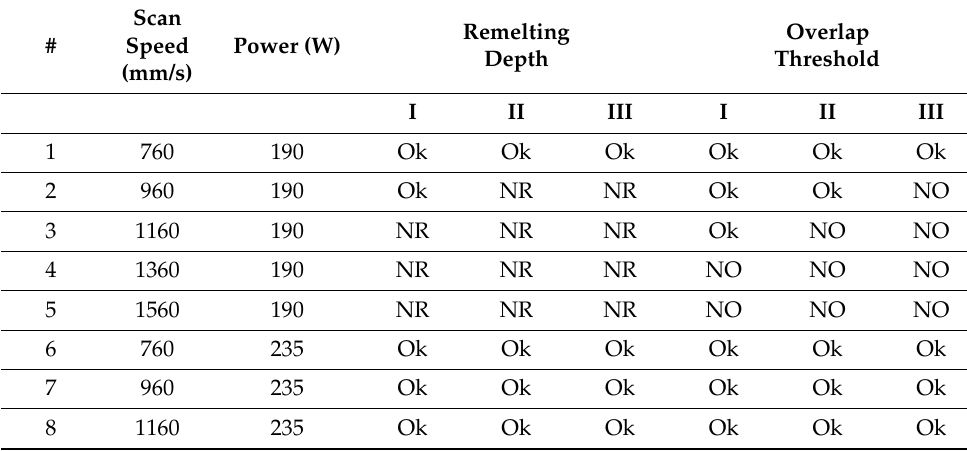
Table 9. Multi-tracks melt pool dimensions tracking table. The measure of each sample is referred to 0.09/0.10/0.11 mm as hatch distance I/II/III, respectively. The abbreviations NR and NO mean, respectively, “Not Remelting” and “Not Overlap”, SS and # mean scan speed and sample